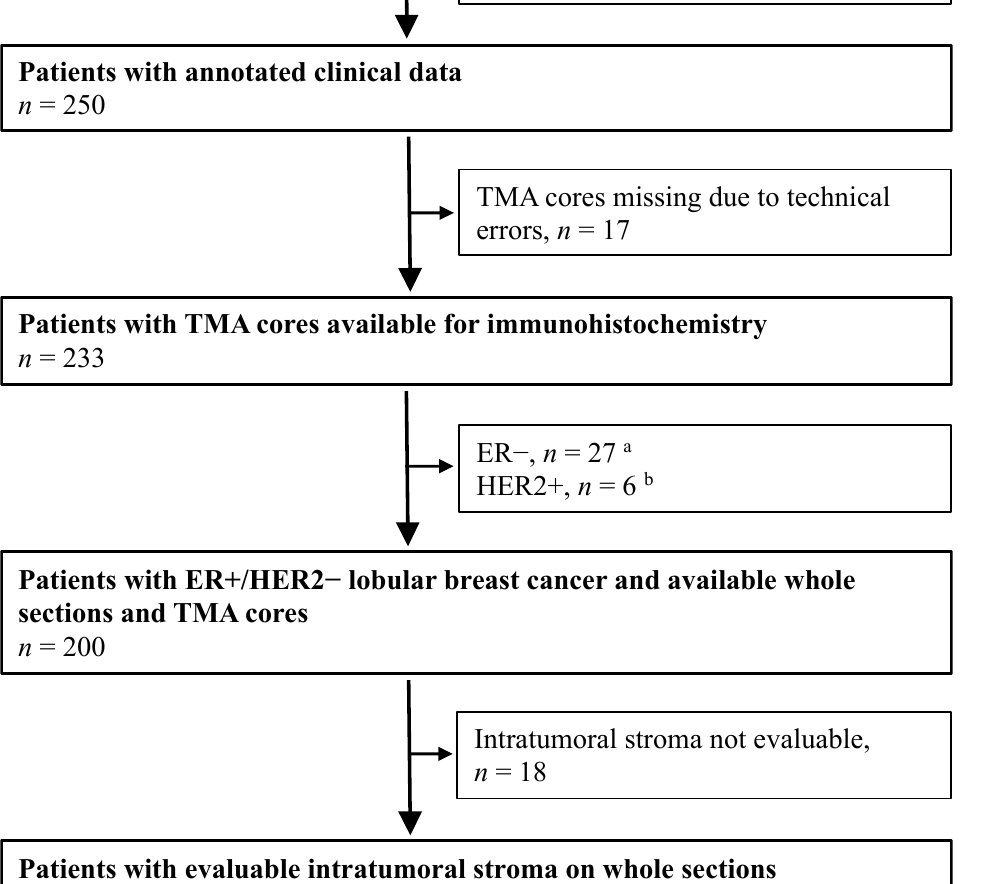
Figure 1. Flowchart of female breast cancer patients with tumors primarily classified as lobular breast cancer at the Departments of Pathology, Skåne University Hospital Lund, and Helsingborg Hospital (1980–1991). a Estrogen-receptor (ER) expression (1D5, DAKO, 1:100) was analyzed through immunohistochemistry (IHC) of whole sections. ER-positivity (+) was defined as >10% stained nuclei. b Human-epidermal growth-factor-receptor-2 (HER2) expression (CB11, Novocastra, 1:200) was analyzed using IHC on tissue microarray (TMA) and categorized into 4 different IHC groups depending on the cell membrane staining intensity: 0, 1+, 2+, 3+. A value of 3+ was considered positive (HER2+). A HER2 amplification test was not performed.